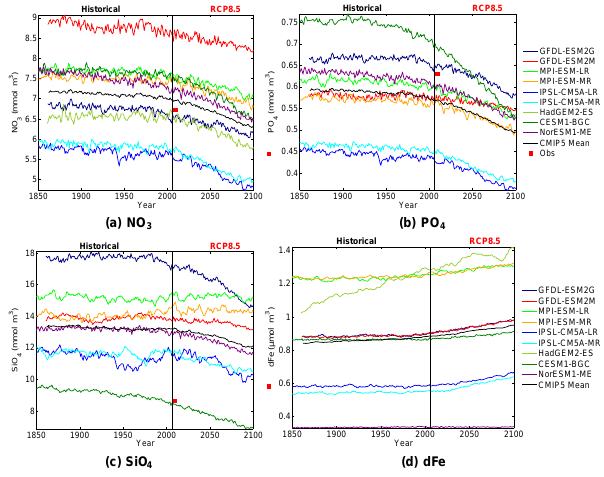
Figure 3. Time series of nitrate (NO 3 ) , phosphate (PO 4 ) , sili- cate (SiO 4 ) and dissolved iron (dFe) concentrations (0–100m) are shown for 1850–2100. Red square indicates WOA2009 global mean values.